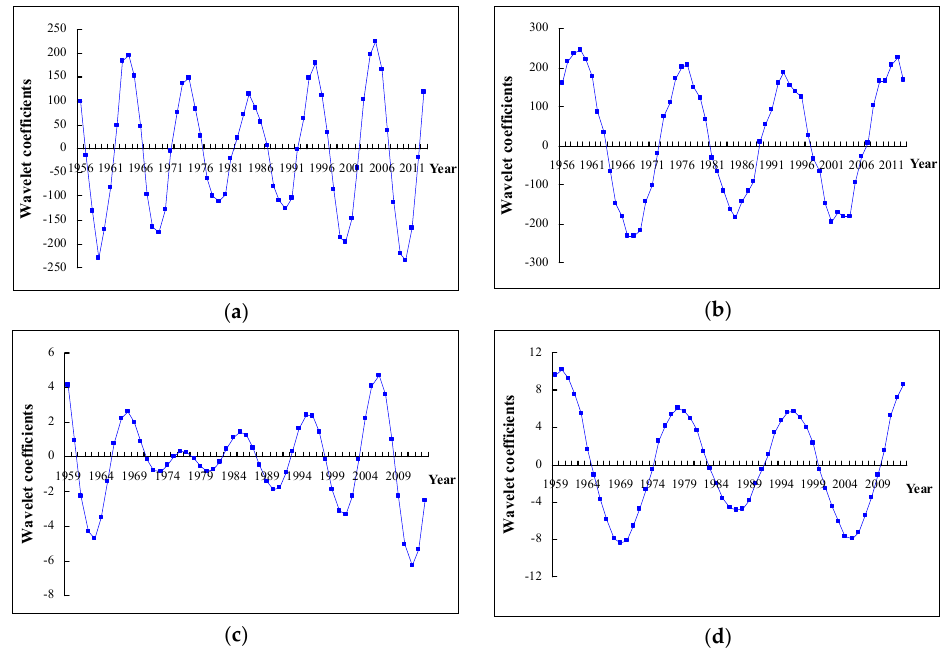
Figure 8. Wavelet coefficient main period chart. ( a ) 15-year scale for atmospheric precipitation; ( b ) 27-year scale for atmospheric precipitation; ( c ) 15-year scale for spring water level; ( d ) 27-year scale for spring water level.